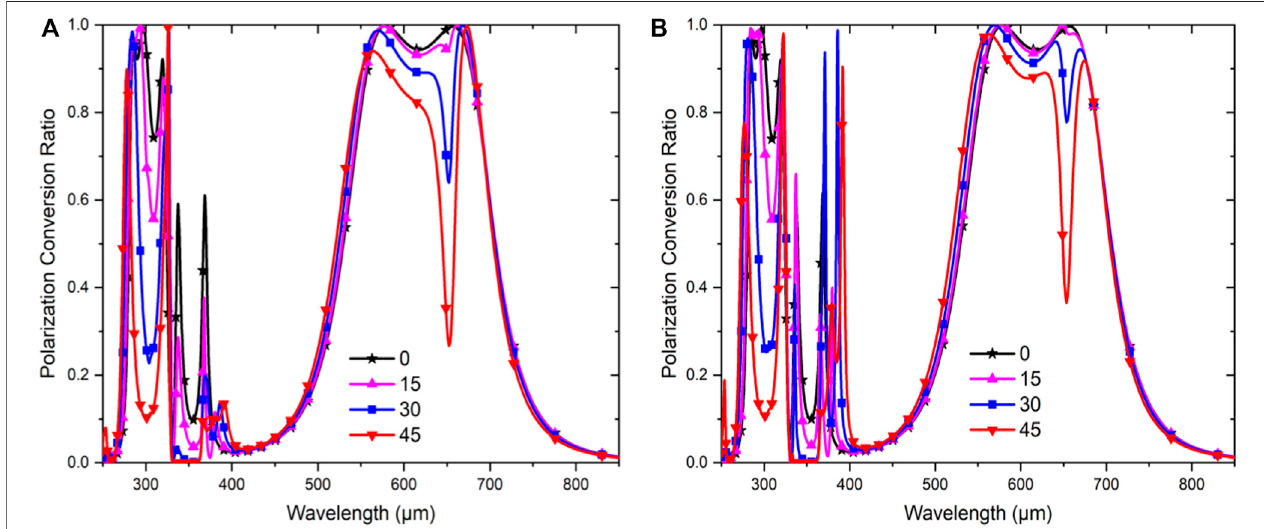
FIGURE 6 | Computed PCR from 0 to 45-degree oblique incidence for (A) y-polarized wave and (B) x-polarized